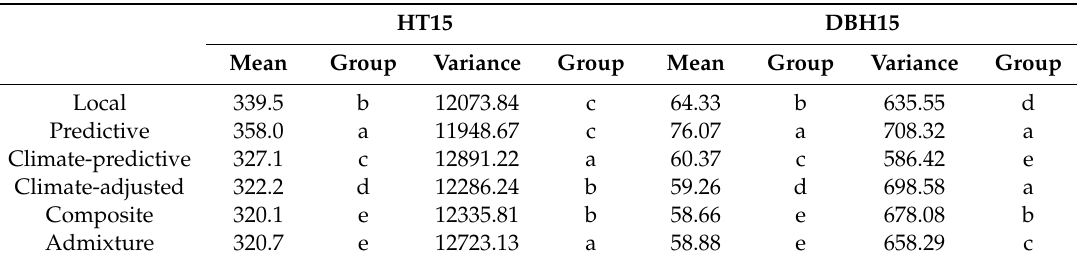
Table 6. Comparison of di ff erent methods for height and diameter at age 15.